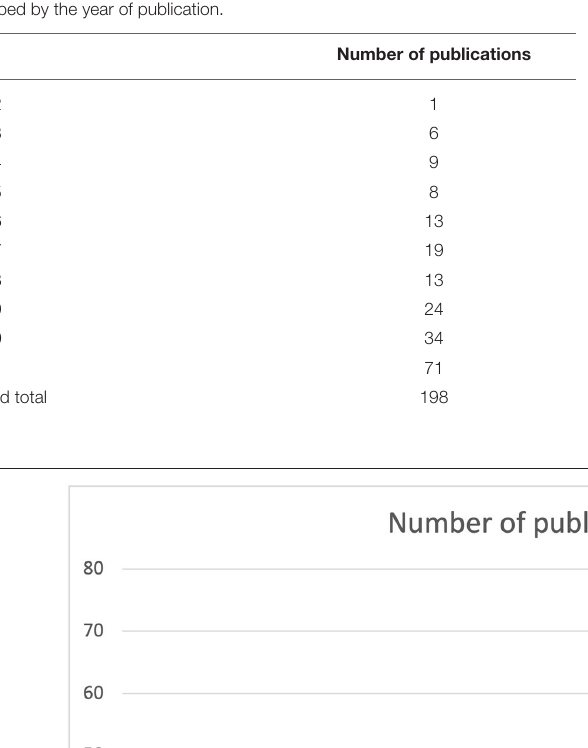
TABLE 1 | Number of publications that could be retrieved from the search as grouped by the year of publication.